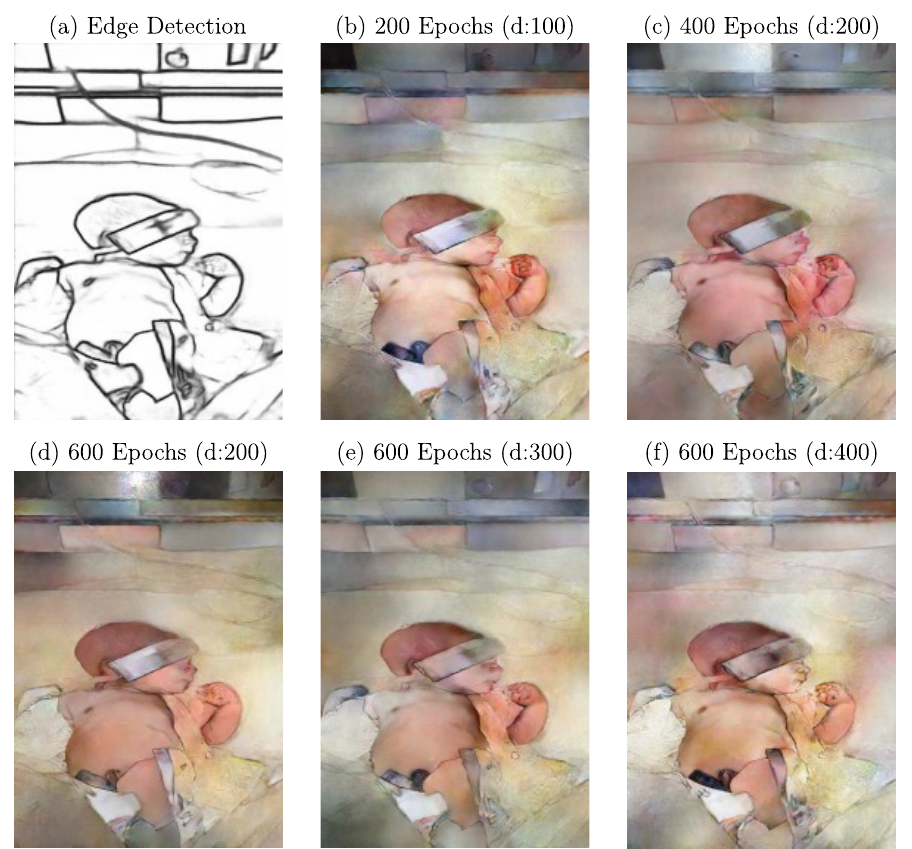
Figure 9. Example edge detection image with resulting images after training with different epochs and